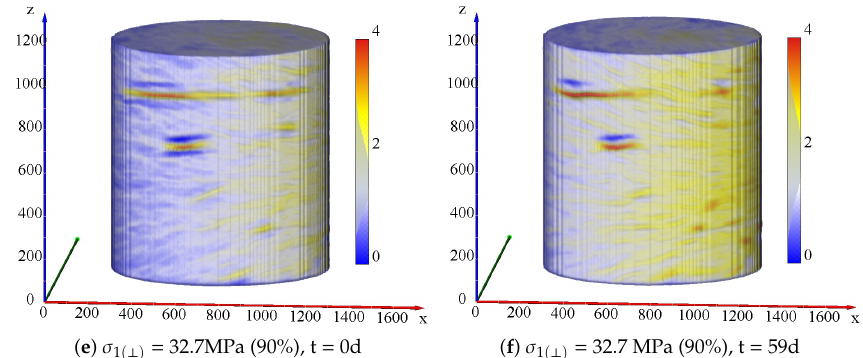
Figure 8. Distributions of accumulated axial strain and at di ff erent instances under a constant stress level: ( a , b ): parallel sample ( (cid:107) ) under q c / q peak = 94%; ( c , d ) inclined sample ( ∥ ) under q c / q peak = 90%; ( e , f ): perpendicular sample ( ⊥ ) under q c / q peak = 90%.